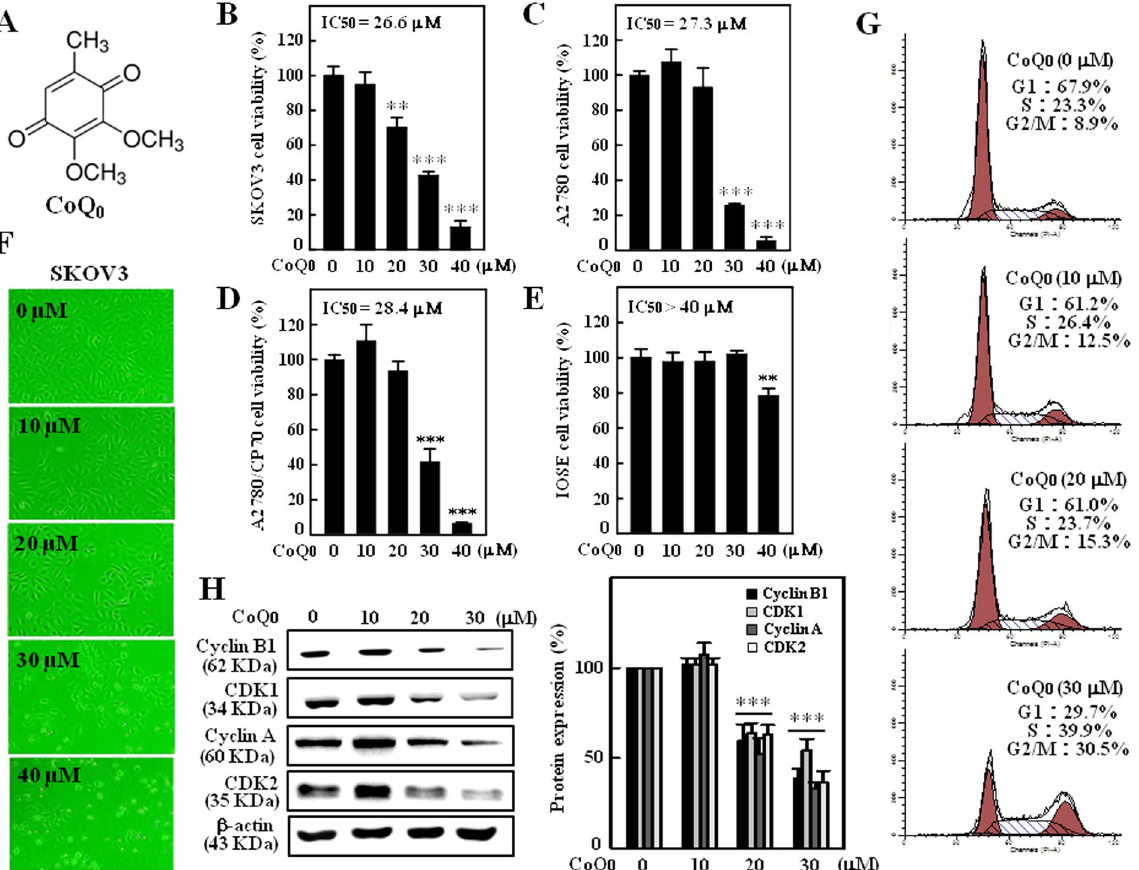
Figure 1. CoQ 0 inhibits growth of human ovarian carcinoma cells and induces G2/M cell-cycle arrest in SKOV-3 cells. ( A ) Structure of CoQ 0 . ( B–D ) Human ovarian carcinoma ( SKOV-3, A2870 and A2870/CP-70) and (E) human ovarian surface epithelial (IOSE) cells were treated with increasing concentrations of CoQ 0 (0–40 µ M) for 24 h. Cell viability was determined using MTT assay. ( F ) Morphological changes in CoQ 0 -treated (0–40 µ M, 24 h) SKOV-3 cells were examined by phase-contrast microscope (200 × magnification). ( G ) SKOV-3 cells were treated with CoQ 0 (0–30 µ M) for 24 h, stained with PI and analyzed for cell-cycle phase using flow cytometry. The cellular distributions (percentage) in different phases of cell-cycle (G1, S and G2/M) were determined after CoQ 0 treatment. Flow cytometry images shown here are from one representative analysis that was repeated three times with similar results. ( H ) SKOV-3 cells were treated with CoQ 0 (0–30 µ M) for 24 h, and cell-cycle regulatory proteins, cyclin B1, CDK1, cyclin A and CDK2 were examined using Western blot. Relative changes in protein intensities were quantified by commercially available software, and presented as histogram, control being as 1-fold. Results expressed as mean ± SD of three independent assays (n = 3), and significant at ** p < 0.01; *** p < 0.001 compared with untreated control